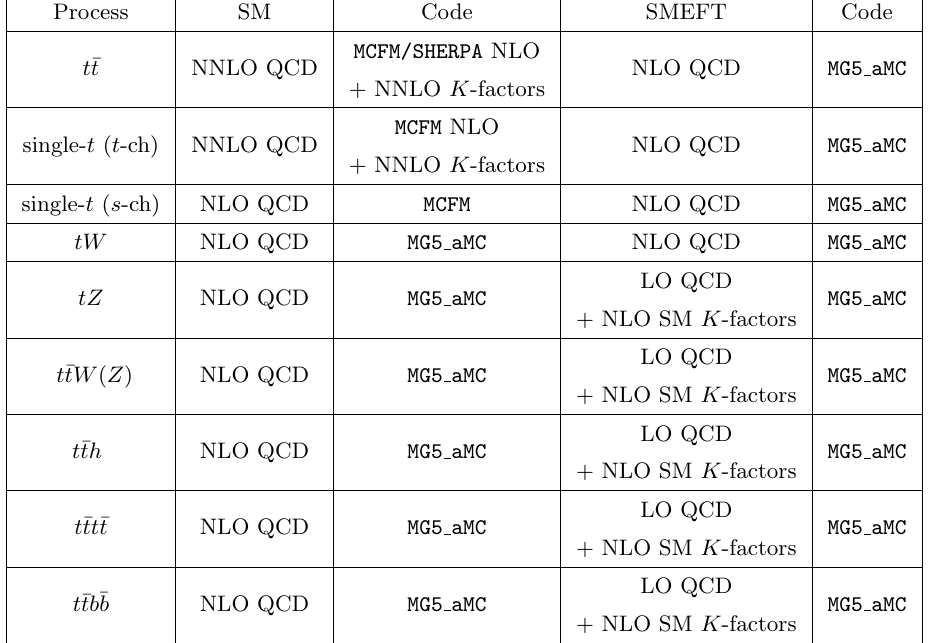
Table 5 . Summary of the theoretical calculations used for the description of the LHC top produc- tion cross-sections included in the present analysis. We indicate, for both the SM and the SMEFT contributions to the cross-sections, the perturbative accuracy and the codes used to produce the corresponding